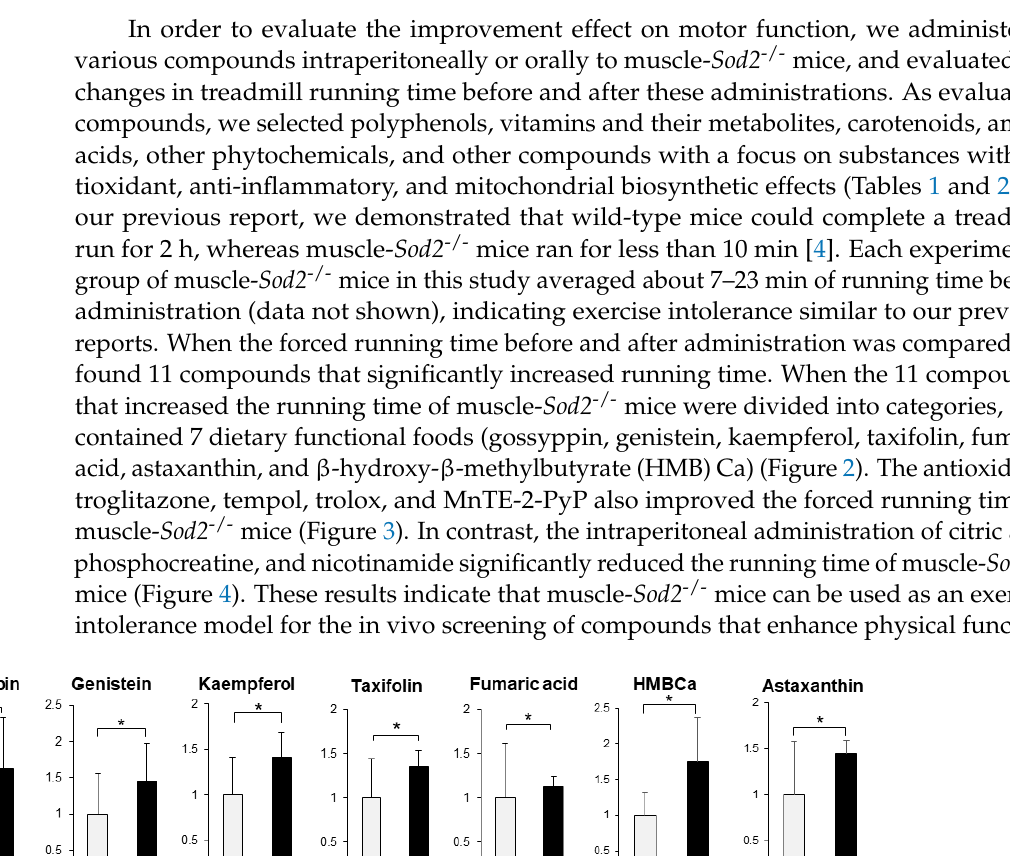
Figure 3. Antioxidants that enhance the running activity of muscle- Sod2 -/- mice. Positive effects of antioxidants on the treadmill task performance of muscle- Sod2 -/- mice (top) and structural formulas of each compound (bottom). * p < 0.05. Data are shown as the mean ± SD.